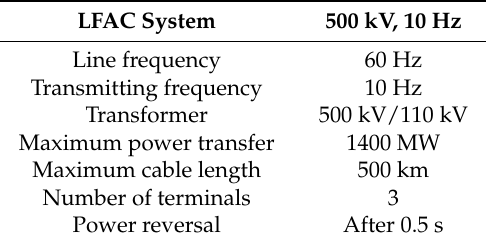
Table 3. Parameters of simulated